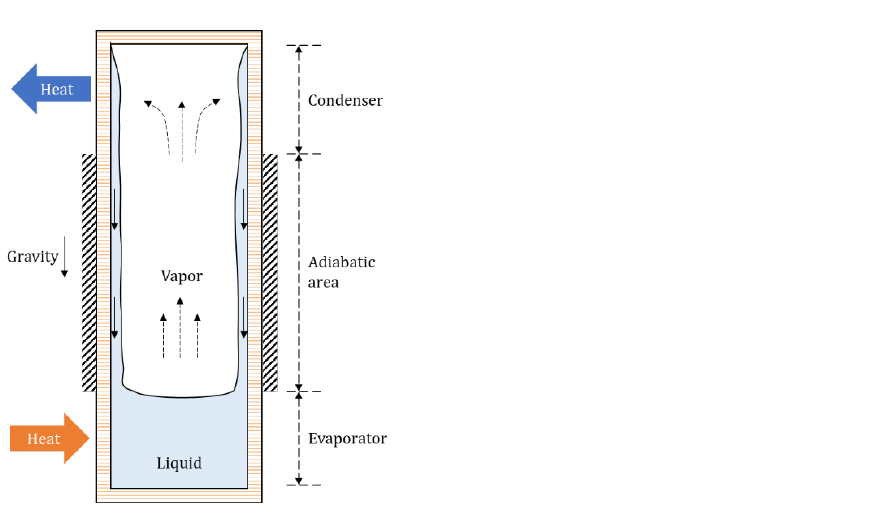
Figure 1. Operating principle of a gravity-aided heat pipe (thermosyphon).